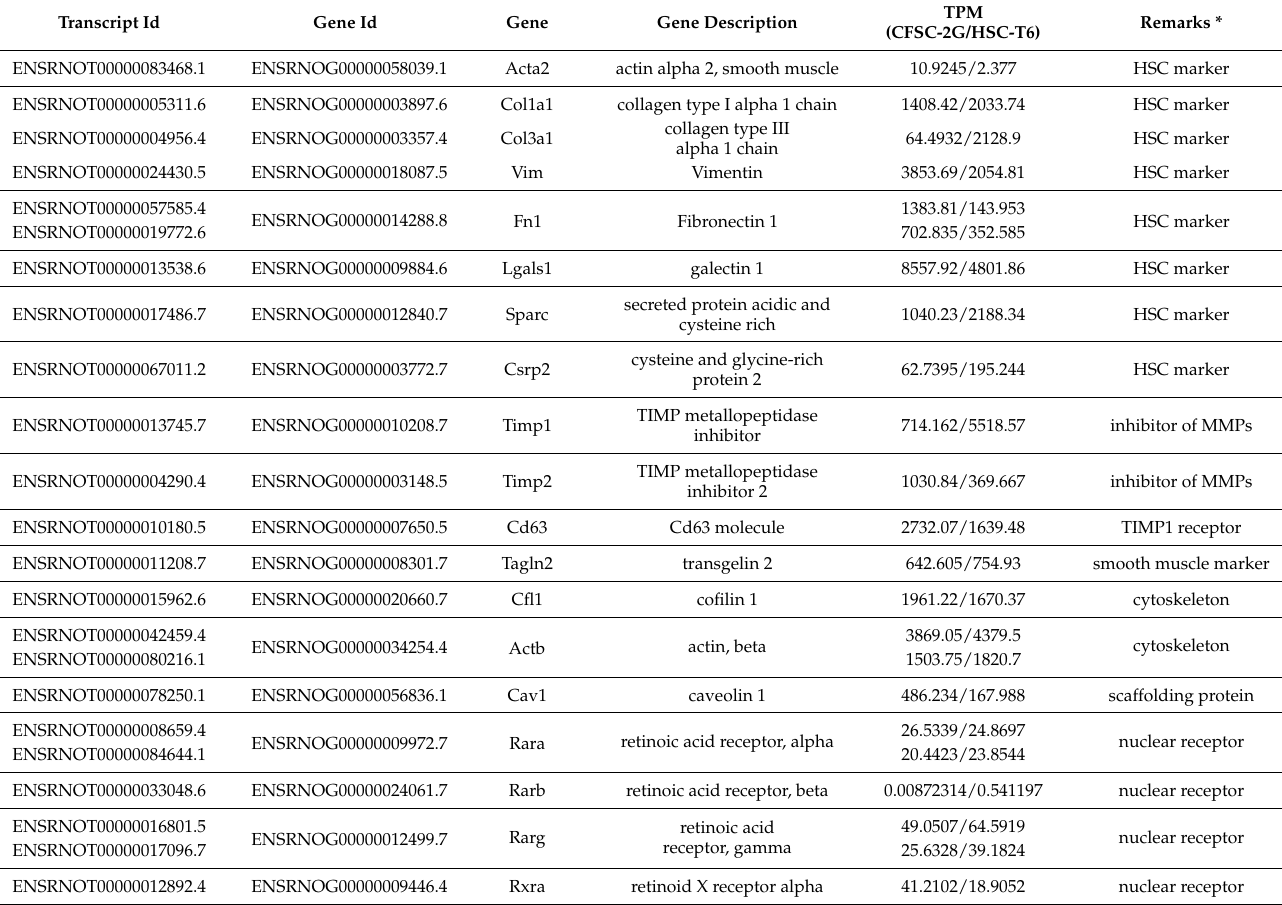
Table 2. Gene expression in CFSC-2G determined by next-generation